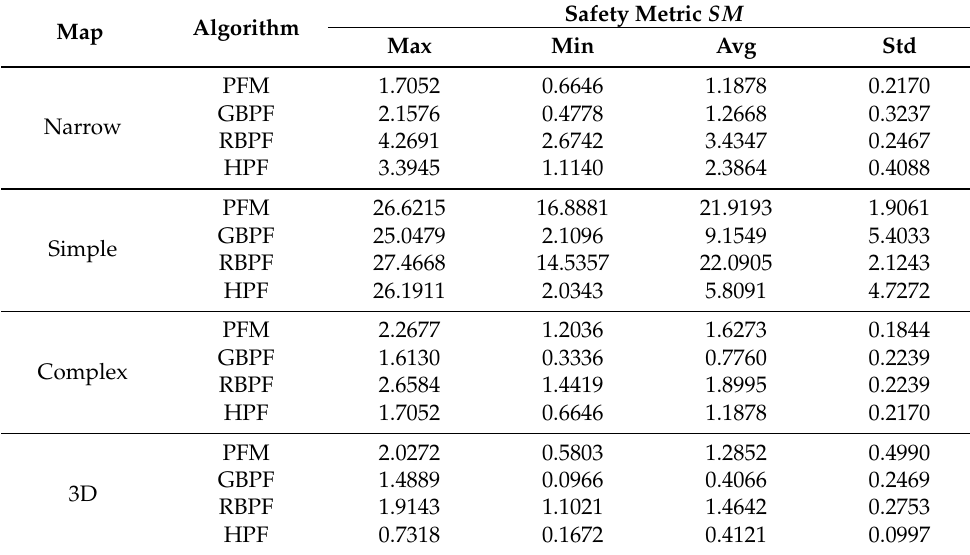
Table 3. Average of the safety measurement for the paths obtained by the algorithms PFM, GBPF, RBPF, and